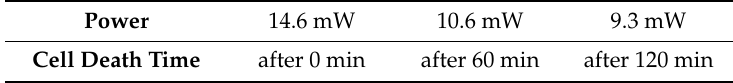
Figure 7. Bright field images of the cells on which the laser treatment was carried out. The color images show the cells dyed with Trypan Blue after the laser treatment. Laser light with different laser powers was employed in the laser treatment experiments. The cells after the irradiation of the laser light were dyed with Trypan Blue after different intervals of time of 0, 30, 60, 90, and 120 min. The blue color appearing in some areas without dead cells is caused by Trypan Blue, which did not diffuse uniformly in the experiment. The length of the scale bar is 20 μ m. Table 1. Summary of the information about the laser power and cell death